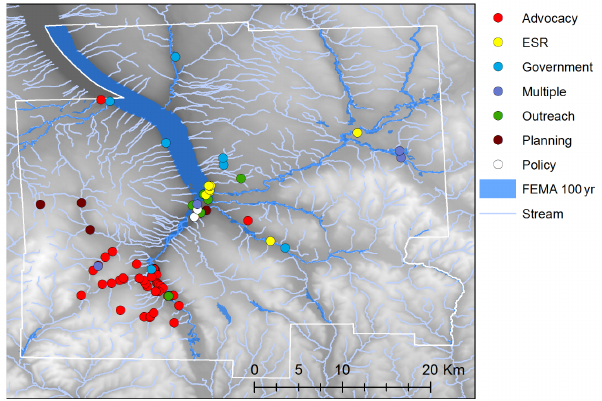
Figure 1. Spatial distribution of survey-reported flooding within Tompkins County (filled circles) and FEMA 100-year flood plain (dark